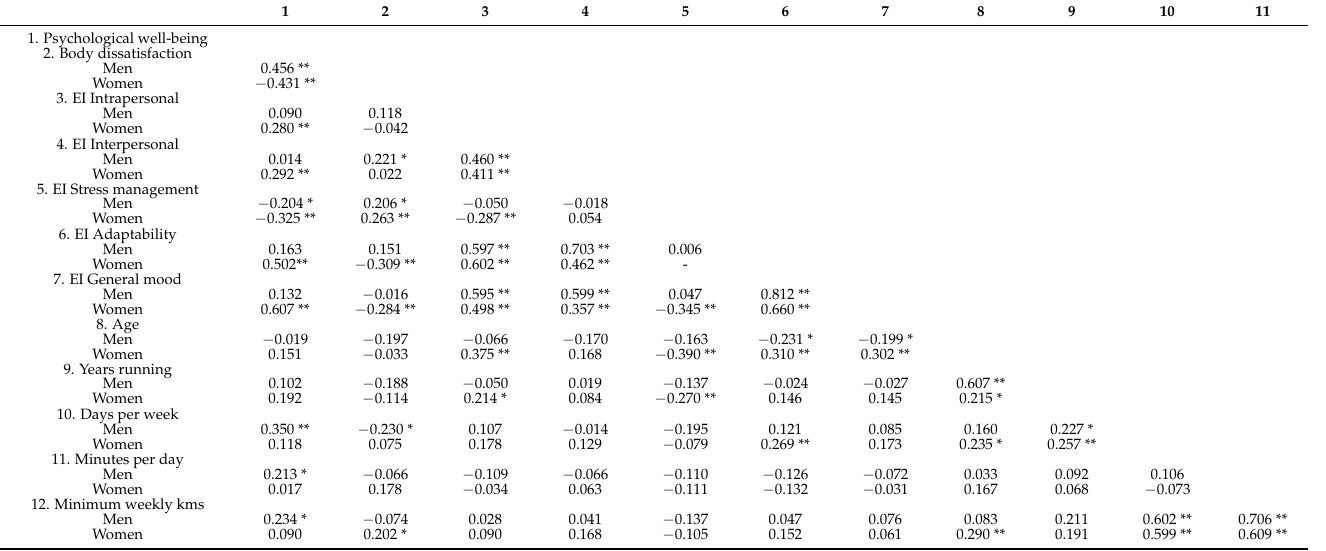
Table 3. Association between psychological well-being, body dissatisfaction, emotional intelligence, and characteristics of running in natural areas.